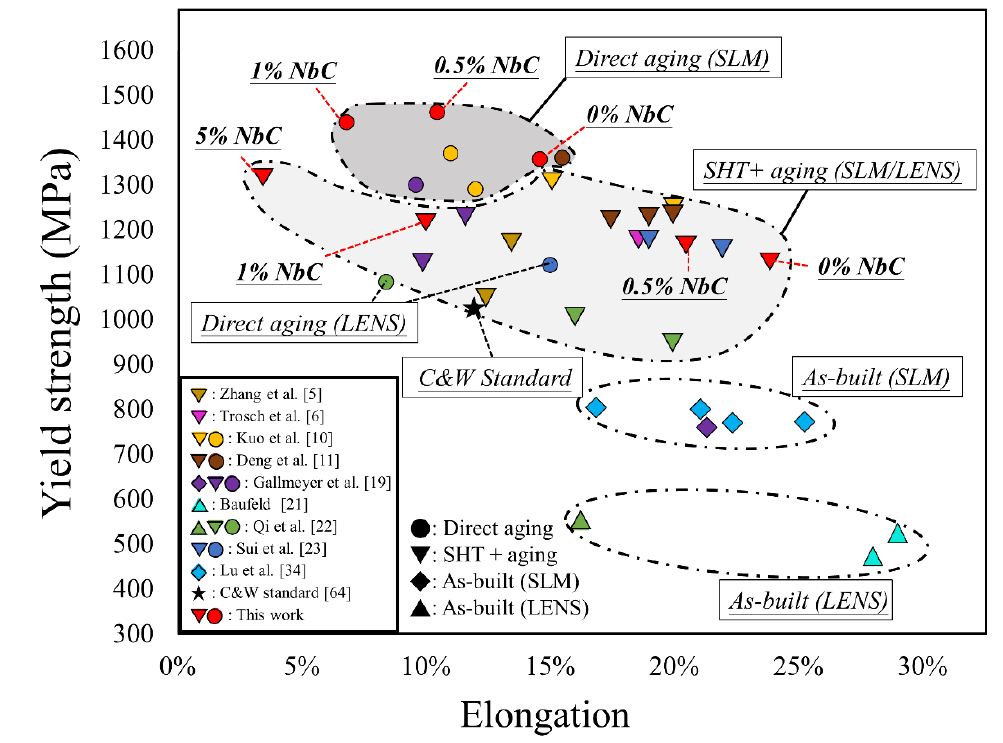
Figure 14. Yield strength of fused-based AM Inconel 718 in this work compared with literature data from [5,6,10,11,19,21–23,34,64].